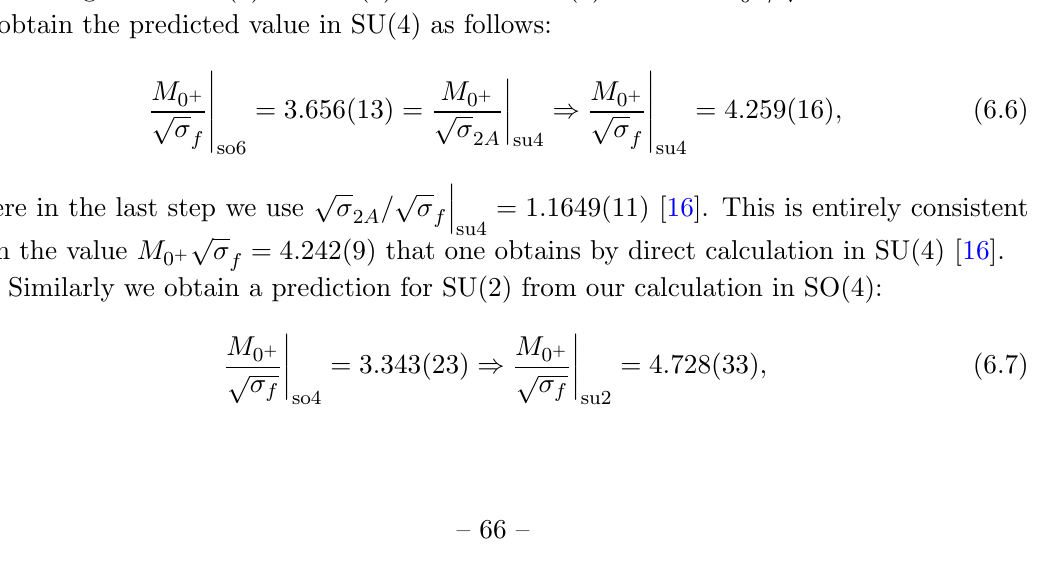
Figure 26 . Mass ratios M Fits shown to guide the